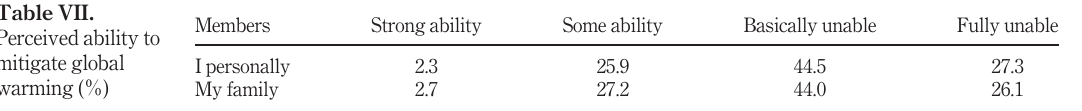
Table VII. Perceived ability to mitigate global warming (%)